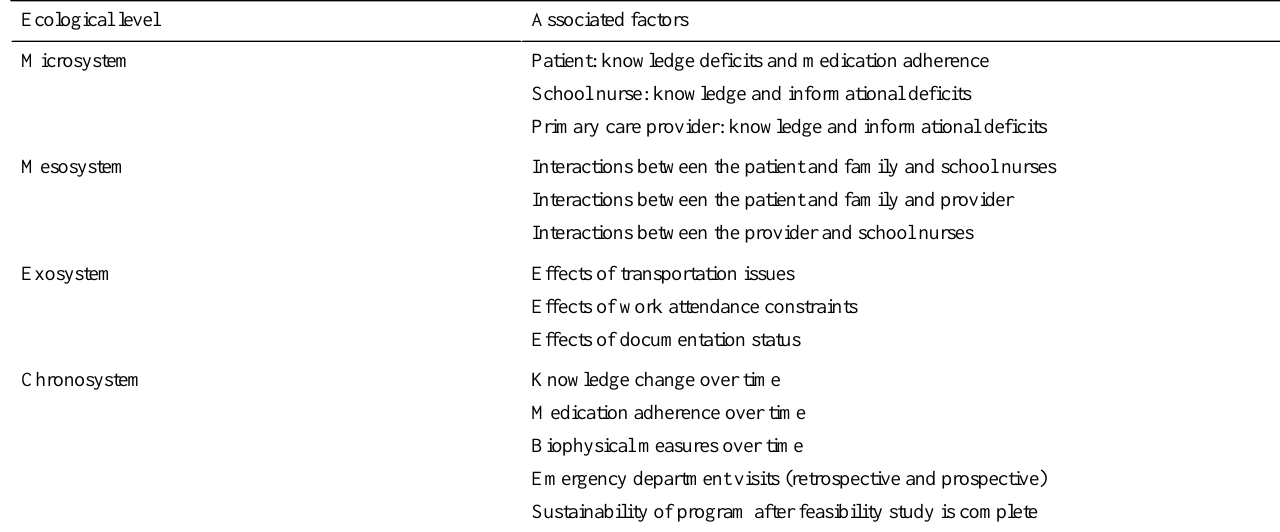
Table 1. Bronfenbrenner’s Process-Person-Context-Time model and ecological levels.